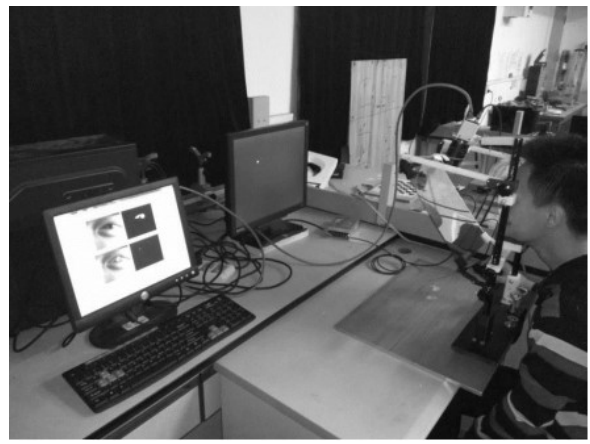
Figure 5. Eye tracker display system.